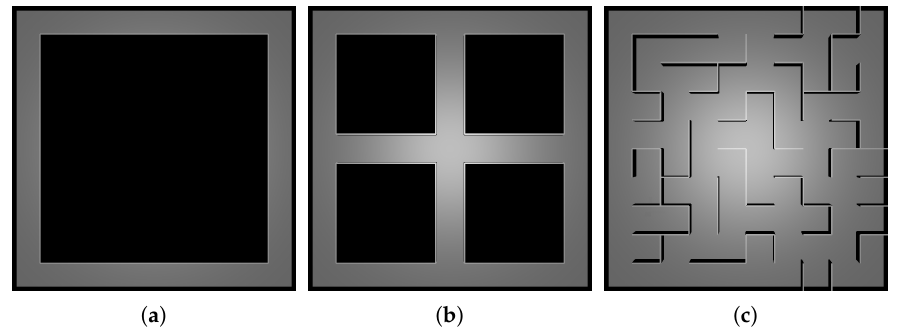
Figure 10. Benchmark scenarios. All terrains cover an 80 including the outer perimeter). Proposed as benchmarks in [45]. ( a ) Loop-like scenario; ( b ) Cross-like scenario; ( c ) Maze-like scenario.